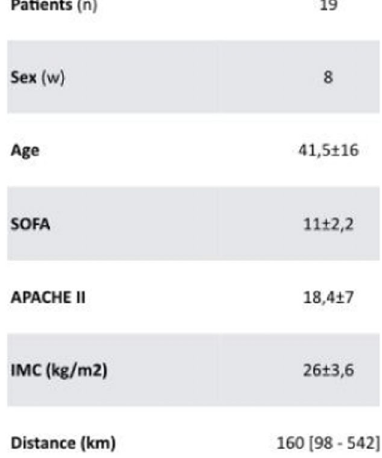
Table 1 (abstract 000914). Demographic characteristics and baseline severity scores